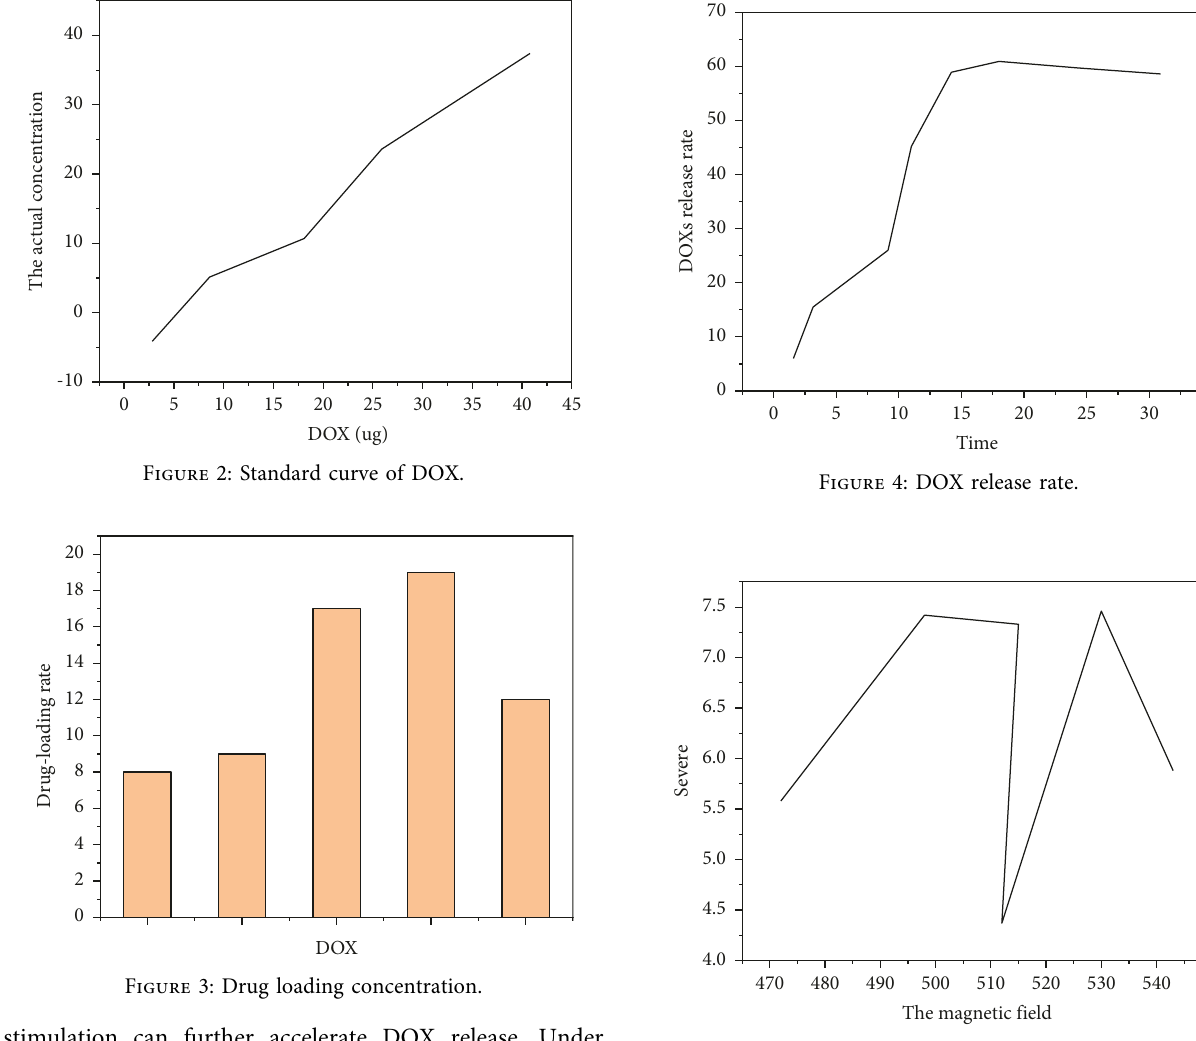
Figure 5: ROS performance.